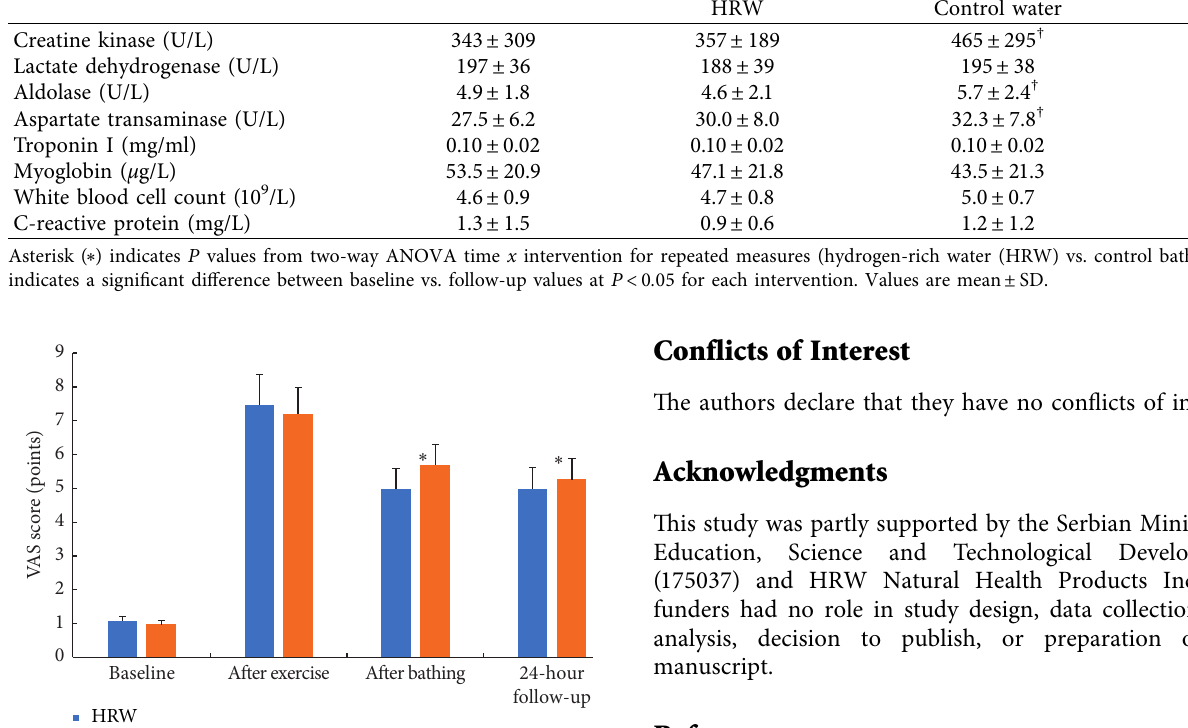
Table 1: Changes in biomarkers of exercise-induced muscular damage ( n � 6). Baseline